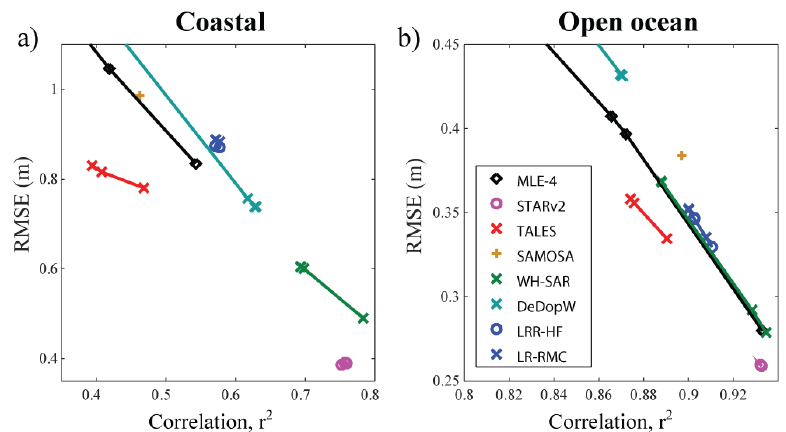
Figure 8. Generally improved performance as minimum no. of valid measurements is increased from 1 to 5 to 10 to 20. The results are displayed for the various different Sentinel-3A algorithms for ( a ) Coastal zone (buoy within 15 km of coastline), ( b ) Open ocean. For many algorithms, their performance with a minimum of one point led to such RMSE as to be plotted off the axes; in nearly all cases, more observations leads to higher r 2 and lower RMSE. Due to the limited flagging on SAMOSA, all its points